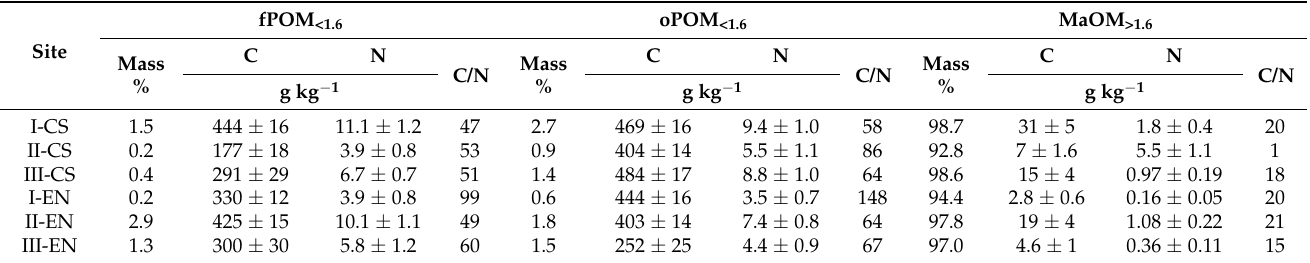
Table 4. Contribution of the fraction and carbon and nitrogen contents in the densimetric fractions of the E pyr horizon.